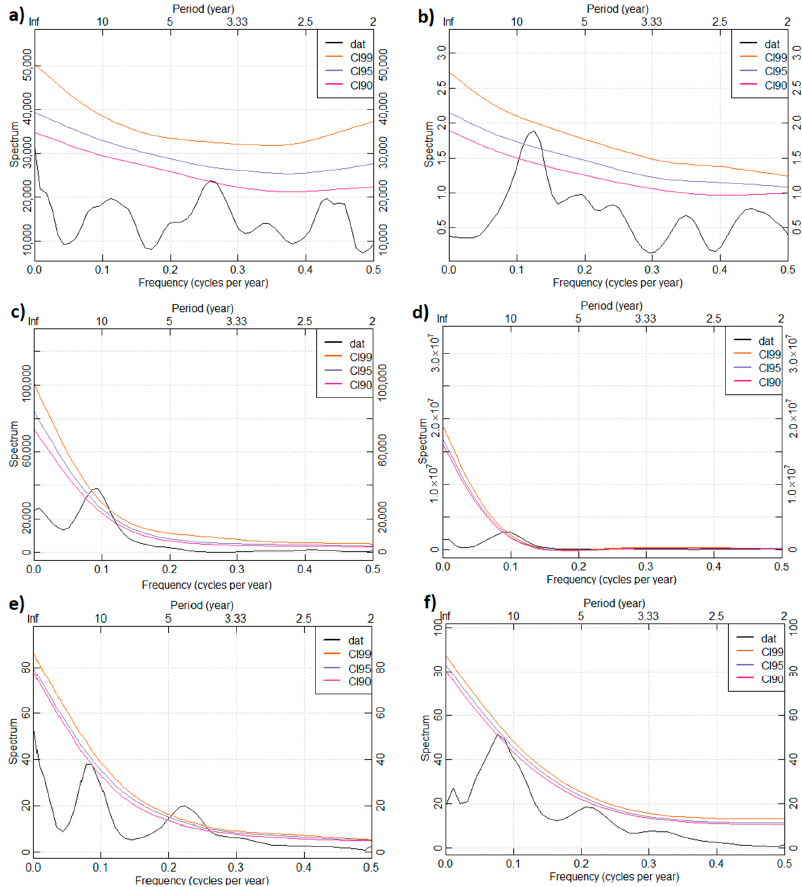
Figure 11. Spectral analyses of the used data in the period 1961–2018: ( a ) Annual precipitation total; ( b ) average annual temperatures; ( c ) cosmic ray intensity; ( d ) sunspot area; ( e ) salvage logging; ( f ) salvage logging in the period 1973–2018. Explanatory notes: the data used are represented by the black curve (dat); the lower, medium and upper parabolic line is significant at a level of 90% (CI90), 95% (CI95) and 99% (CI99), respectively; the period (year) shown on the upper x-axis ranges from 2 years to infinity (Inf).